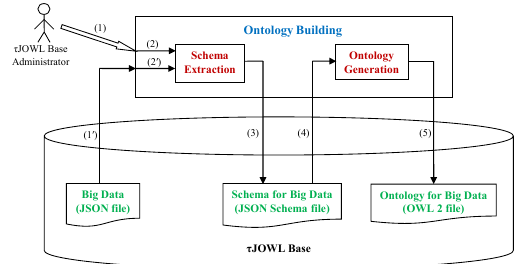
Fig. 1 The first part of the (cid:28)(cid:28)(cid:28) JOWL